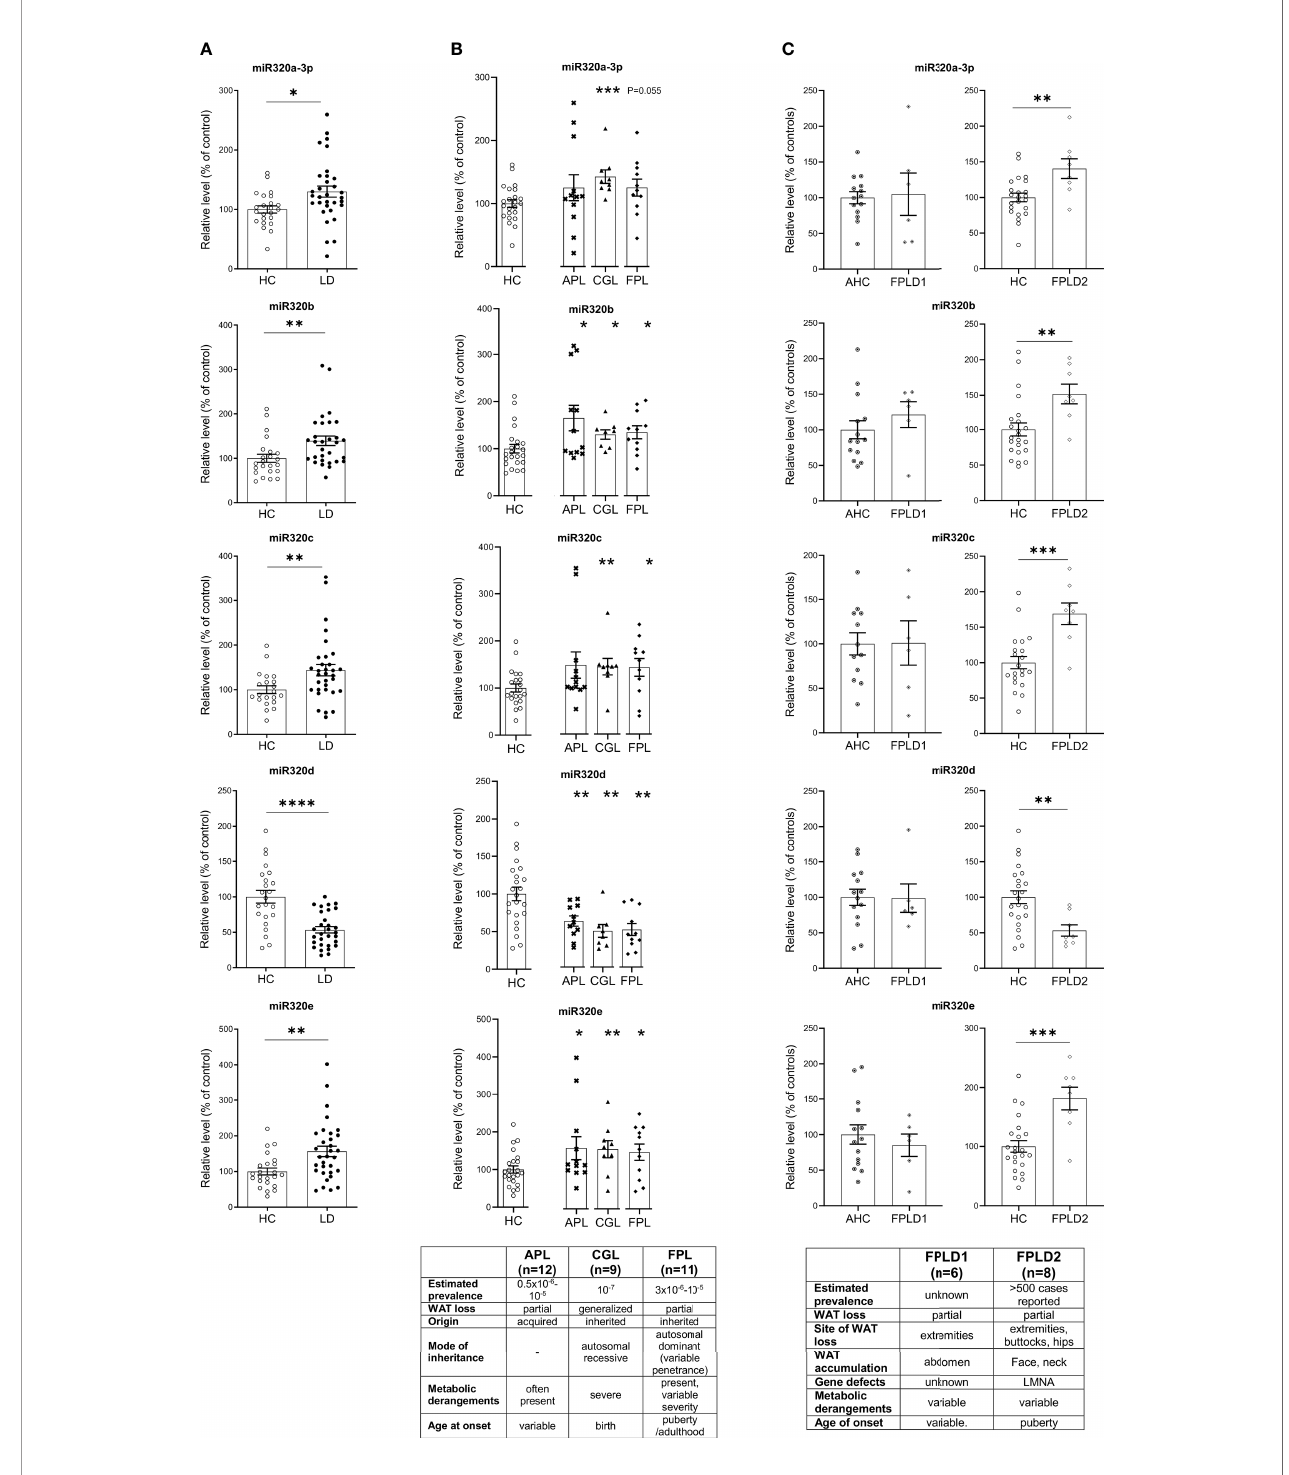
FIGURE 2 | Relative level of cmiRs-320 in LD and HC subjects. (A) Scatter plots with error bar of cmiRs 320 in a) LD (n = 32) versus HC (n = 23). (B) in APL (n = 12), CGL (n = 9), FPL (n = 11) versus HC. Each asterisk denotes a pairwise comparison of 2 groups. (C) FPLD1 ( n = 6) versus an ad-hoc selected group of age matched controls Adult Healthy Controls (AHC) ( n = 14) and FPLD2 ( n = 8) versus HC. Data, expressed as percentage of the mean of HC or AHC (in the case of FPLD1), are shown as mean ± SEM (standard error of the mean). * P < 0.05, ** P < 0.01, *** P < 0.001, **** P < 0.0001, by Student ’ s t test or Mann-Whitney as